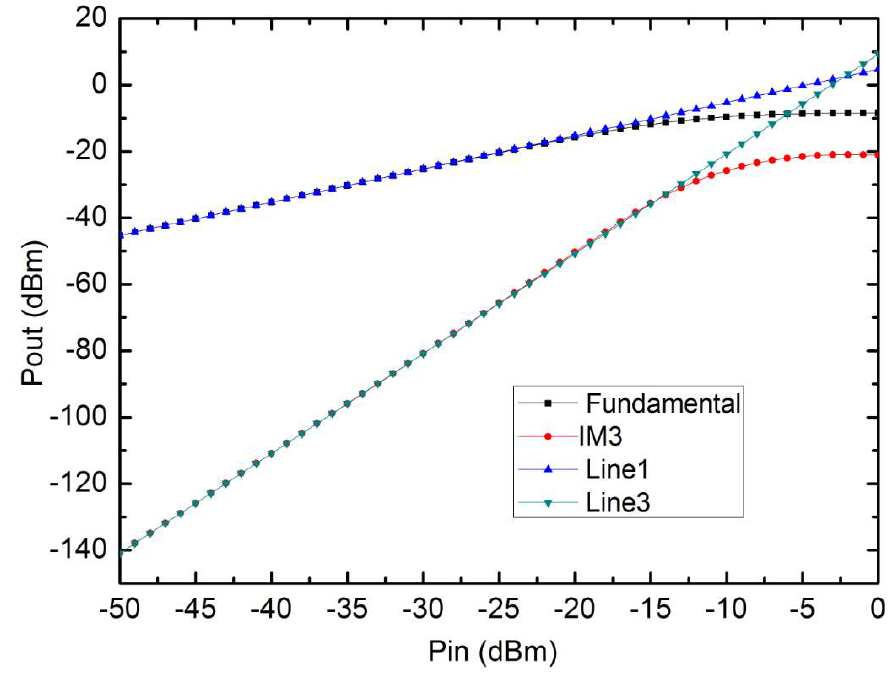
Figure 10. Simulated IIP3 and P1dB of the wideband LNA. Table 1. Performance summary of the proposed LNA and comparison with other